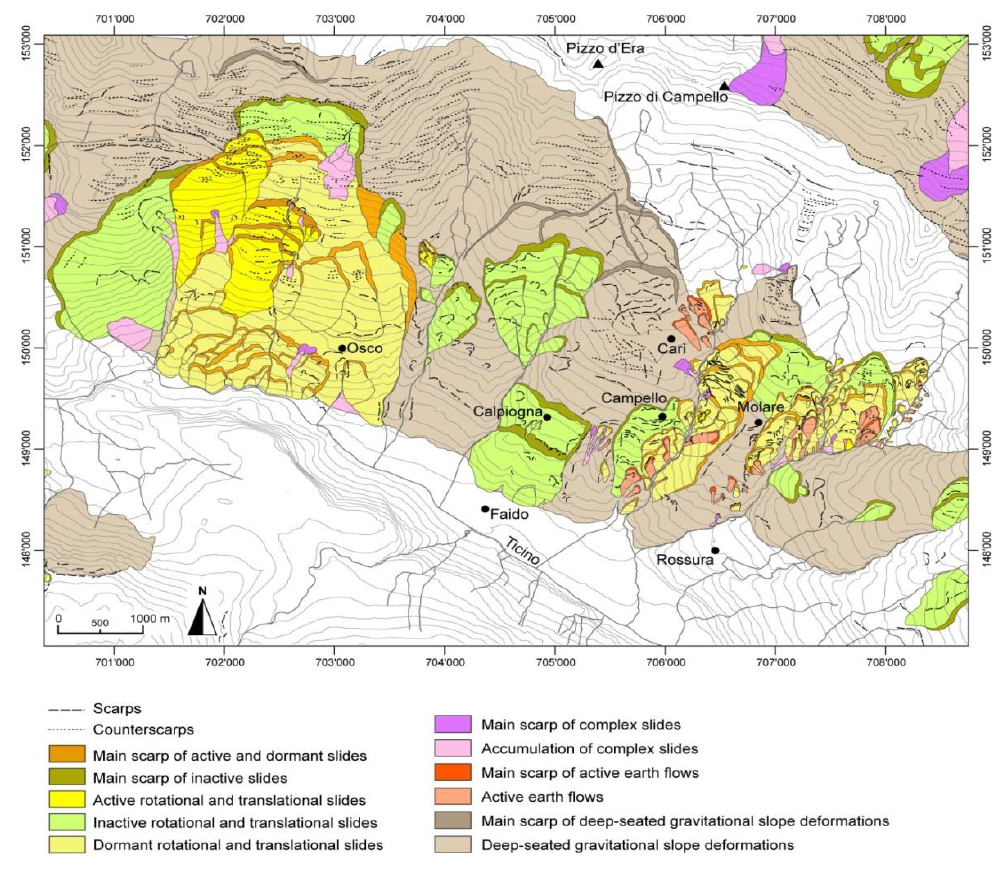
Figure 3. Sketch map of the deep-seated landslide in Osco from aerial photography interpretation with geomorphological features. The grid indicates the easting and northing coordinates in meters in the Swiss geographical